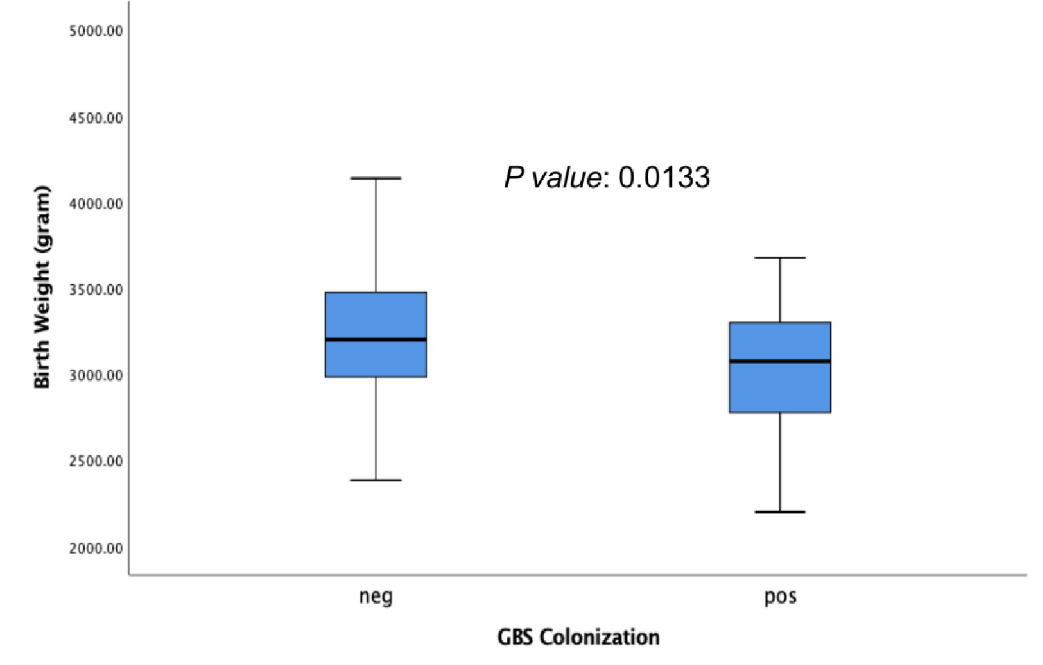
Fig 1. Correlation between birth weight of newborns and mother with negative (neg) and positive (pos) for GBS colonization. (total participants: 38 women) from a similar area in Jakarta, were colonized with GBS [9]. In this study, we found that GBS colonized mothers were more likely to have newborns with lower birth weight (Fig 1). Maternal GBS colonization was previously reported to be associated with an increased risk of delivering a preterm, low-birth-weight infant [21]. Russell et al reported that GBS serotypes Ia, Ib, II, III, and V accounted for 98% of identified colonizing GBS isolates worldwide [5]. In Asia, serotype VI, VII, and VIII more frequently found [5]. Meanwhile, in our study, serotypes II, III, Ia, and IV accounted for 79% of all the GBS strains isolated from Indonesian pregnant women. Recently, Botelho et al reported that serotype II was the second most frequent serotype among 689 GBS isolates from pregnant women living in Rio de Janeiro, Brazil, over a period of eight years [19]. In African countries, the V, III, Ia, Ib, and II serotypes accounted for 91.8% of isolates [22]. Africa et al reported that in pregnant women from Western Cape, South Africa, the most common serotype were sero- type V (67%), followed by serotype III (21%) [23]. In addition, among Gambian mothers, the predominant serotype was serotype V (55%), followed by II (16%), III (10%), Ia and Ib (each 8%) [24]. In another study in Toronto, Canada, the most frequently identified serotypes found among healthy pregnant women were III (25%), followed Ia (23%) and V (19%)[25]. In our study, we observed that the prevalence of serotype II was higher than other studies in Asia. In a systematic review, in mainland China, the five GBS serotypes (Ia, Ib, II, III, and V) accounted for the majority of the cases of GBS disease [21], but GBS serotype III was the dominant sero- type observed colonizing pregnant women in Beijing [26]. Saha et al reported that serotype Ia was the most common serotype (40%) found in pregnant women in Mirzapur, Bangladesh, followed by serotype V (23%), II (14%), and III (12%) [7]. In Kuwait, serotype V was the most predominant serotypes among GBS isolates (39%) isolated from mothers, followed by III (21%), Ia (8%), and II (11%) [27].